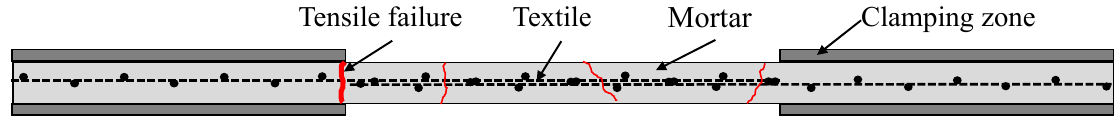
Figure 10. Failure mode from the uniaxial tensile test of TRM coupons.